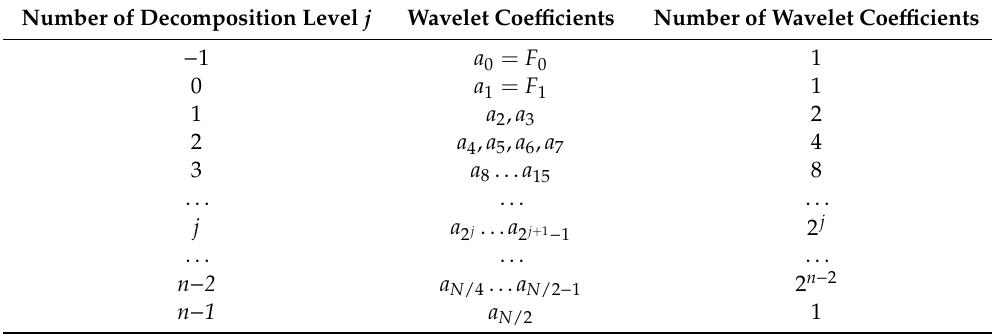
Table 1. Distribution of wavelet coe ffi cients among decomposition levels. Number of Decomposition Level j Wavelet Coe ffi